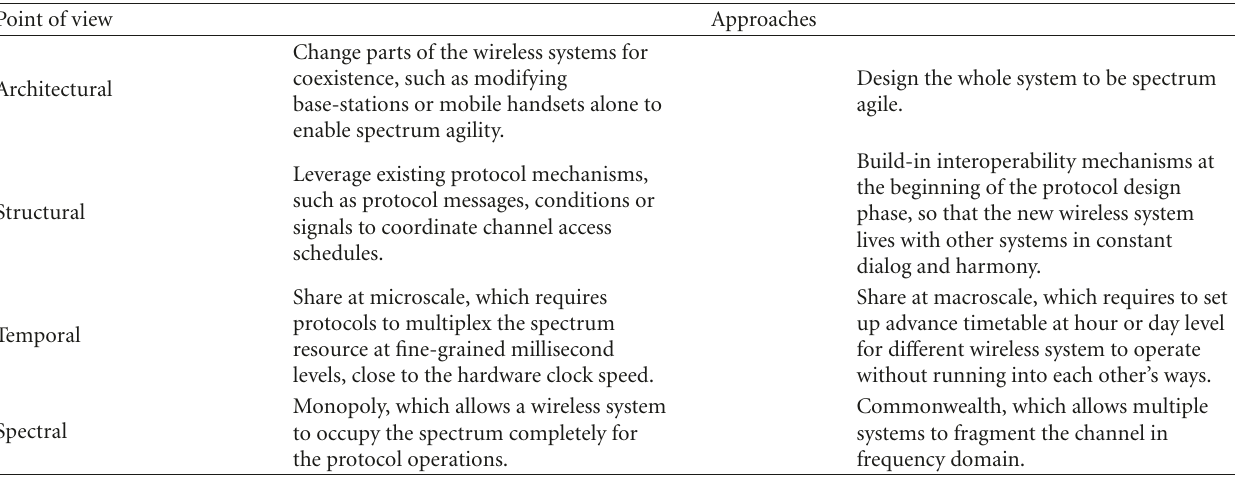
Table 1: Design perspectives to achieve coexistence of heterogeneous systems.